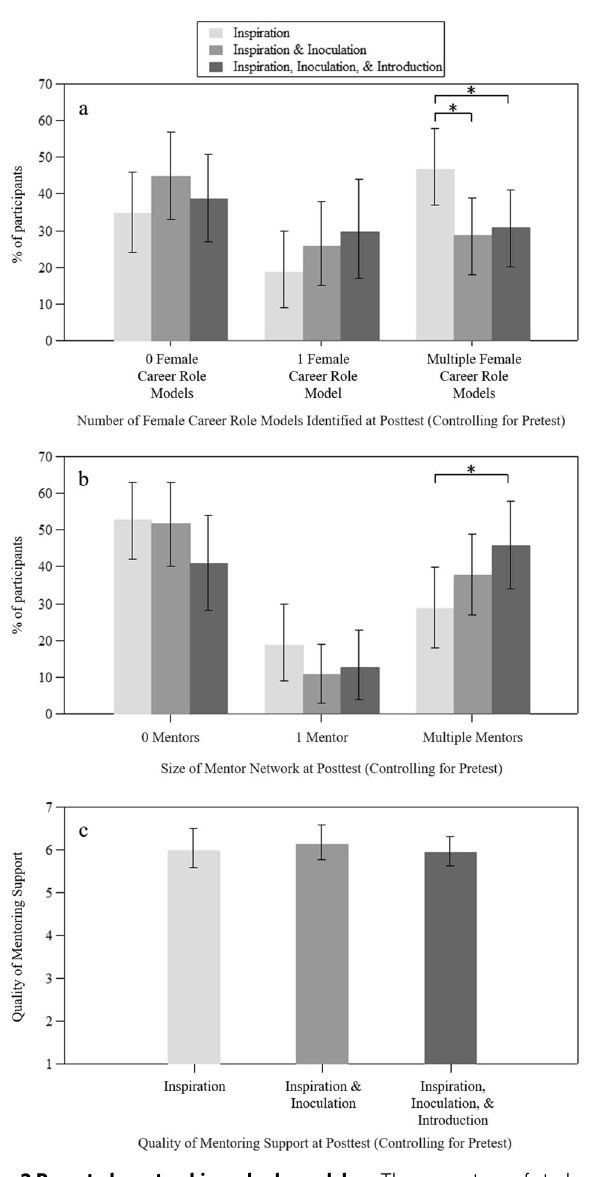
Fig. 2 Reported mentorship and role models. a The percentage of students reporting 0, 1, or multiple female career role models, b percentage of students reporting 0, 1, or multiple mentors, and c average quality mentorship support received as a function of group, controlling for pretest. Notes: Bar graph values represent percentages or means. Error bars re fl ect the lower and upper limits of bias-corrected bootstrapped 95% con fi dence intervals. Asterisks are used to highlight where groups differences are statistically signi fi